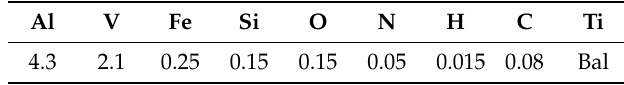
Table 1. Main chemical compositions of Ti–4Al–2V (TA17). (wt.